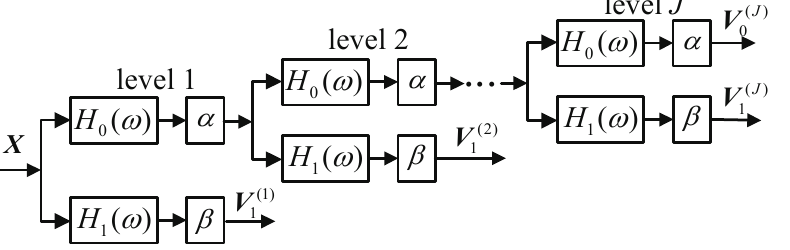
Figure 2. The cascaded filter banks of